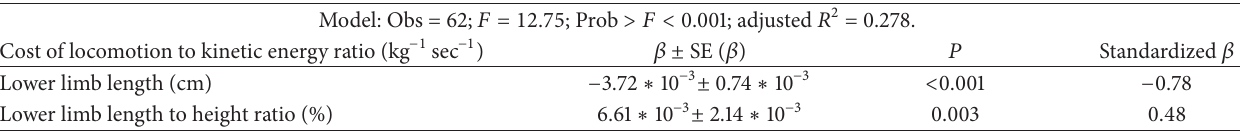
Table 2: Multivariable regression model testing the association of the energy cost of overground walking with anthropometric measures. Model: Obs = 62; 𝐹 = 12.75 ; Prob > 𝐹 < 0.001; adjusted 𝑅 2 =